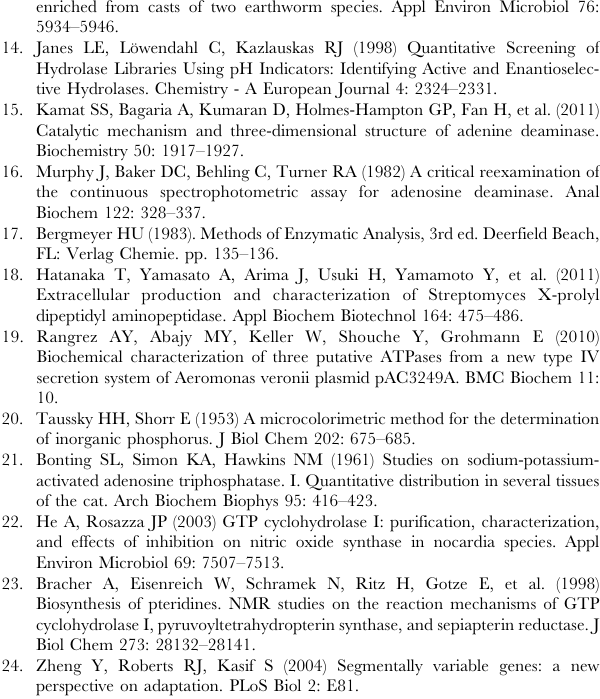
Figure S1 SDS-PAGE analysis of Coomassie-stained proteins isolated using derivatized gold nano-particles. In four of the five instances only a single intense band is observed. In lane 5, two bands were observed, which were identified using mass spectrometry as HP0803 and HP0959. GTP cyclohydrolase activity was observed for HP0959, however HP0803 resisted multiple attempts at cloning and expression in E. coli , it was not pursued further. HP0803 only has one know protein domain, DUF3943 (PF13084), and so its reason for binding to the derivatized nano particle coated with guanosine-5’-triphosphate (GTP) and dihydroneopterin triphosphate is unexplained. (Data for HP0310 not